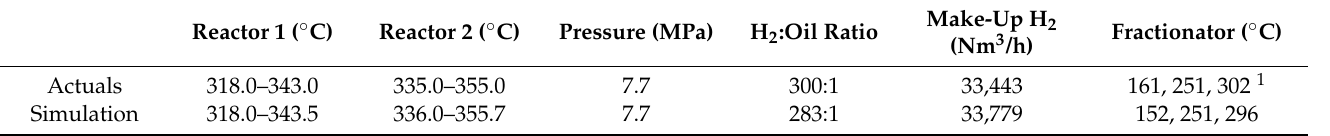
Table 2. Comparisons of main operating